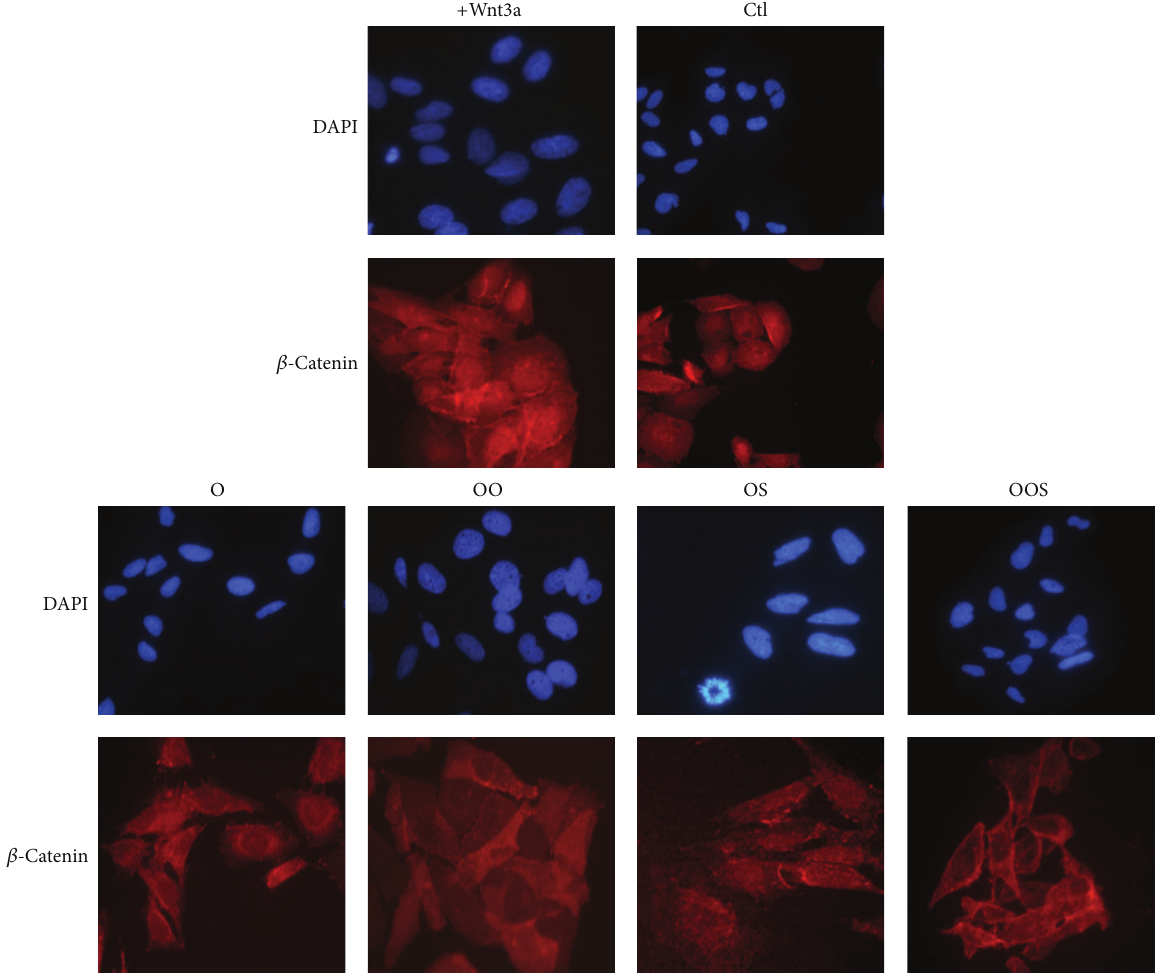
Figure 5: Characterization of 𝛽 -catenin localization by immunofluorescence analysis in osteoblastic cells grown as described in Figure 1. A representative experiment of the three performed is shown in the figure. Magnification